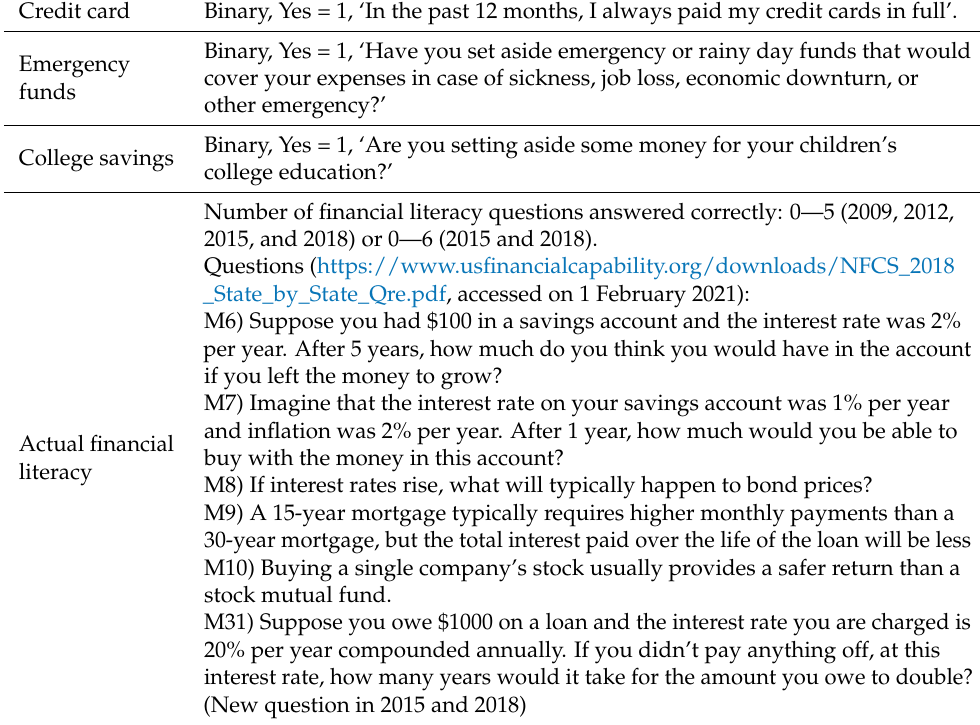
Table A1. Description of data